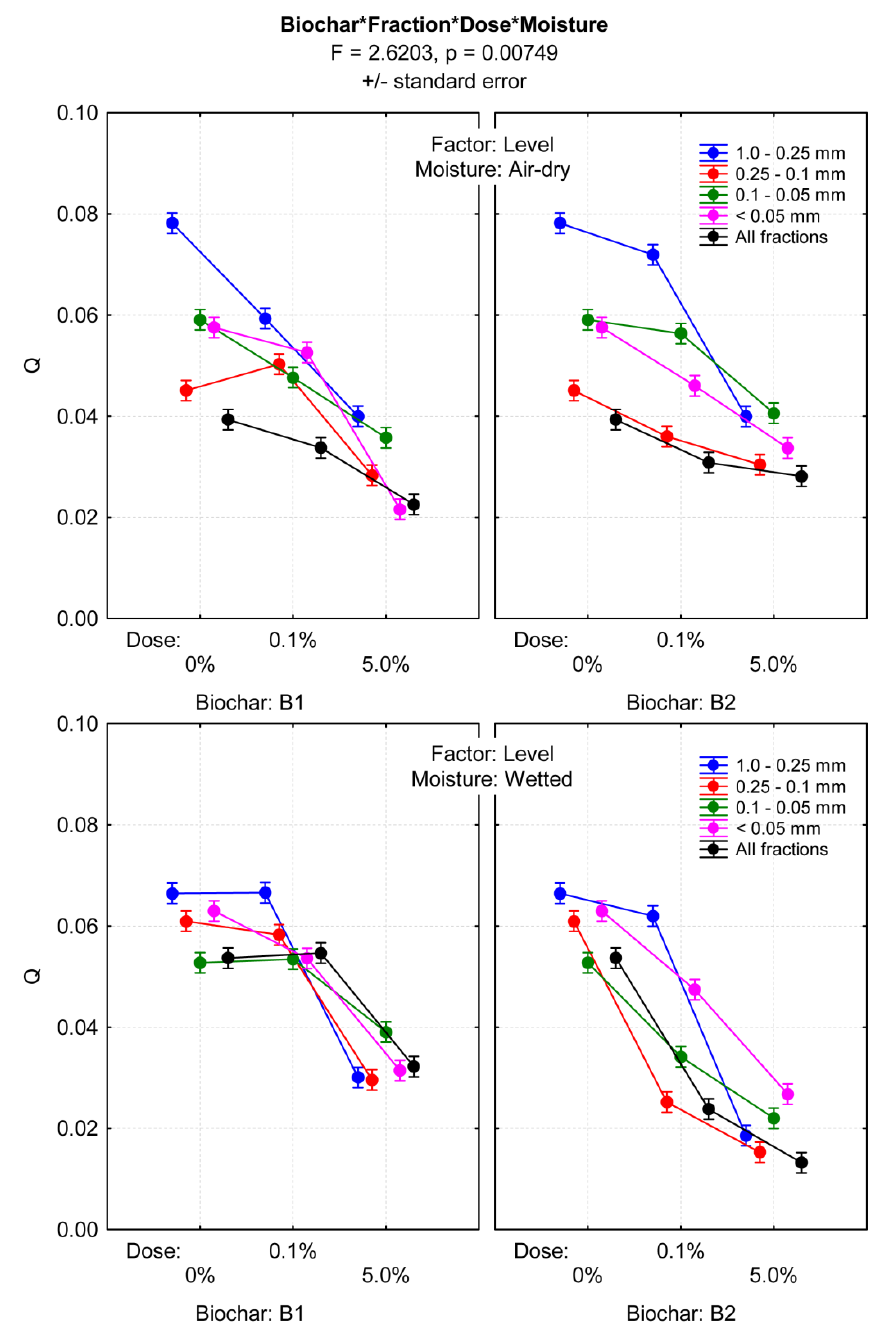
Figure 11. Multivariate ANOVA for four factors (biochar type, biochar dose, soil fraction, and sample moisture) and one variable Q (tensile strength) for air-dried and wetted cylinders.